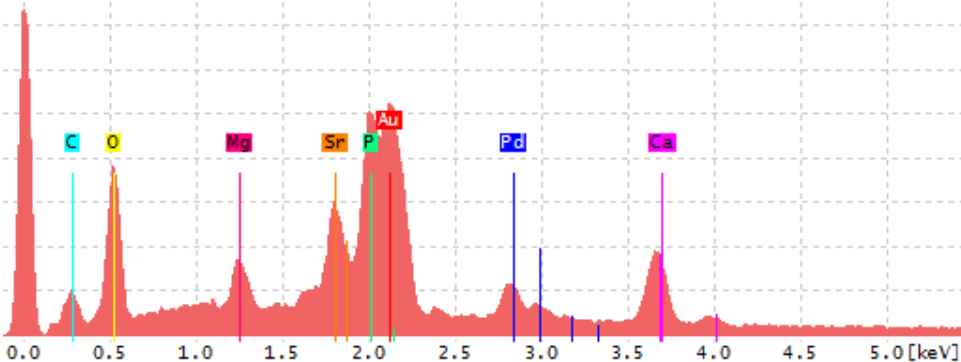
Figure A2. The characteristic energy dispersive X-ray analysis spectra showing peaks corresponding to the elements in the 5-Mg-5-Sr-CaP scaffold.